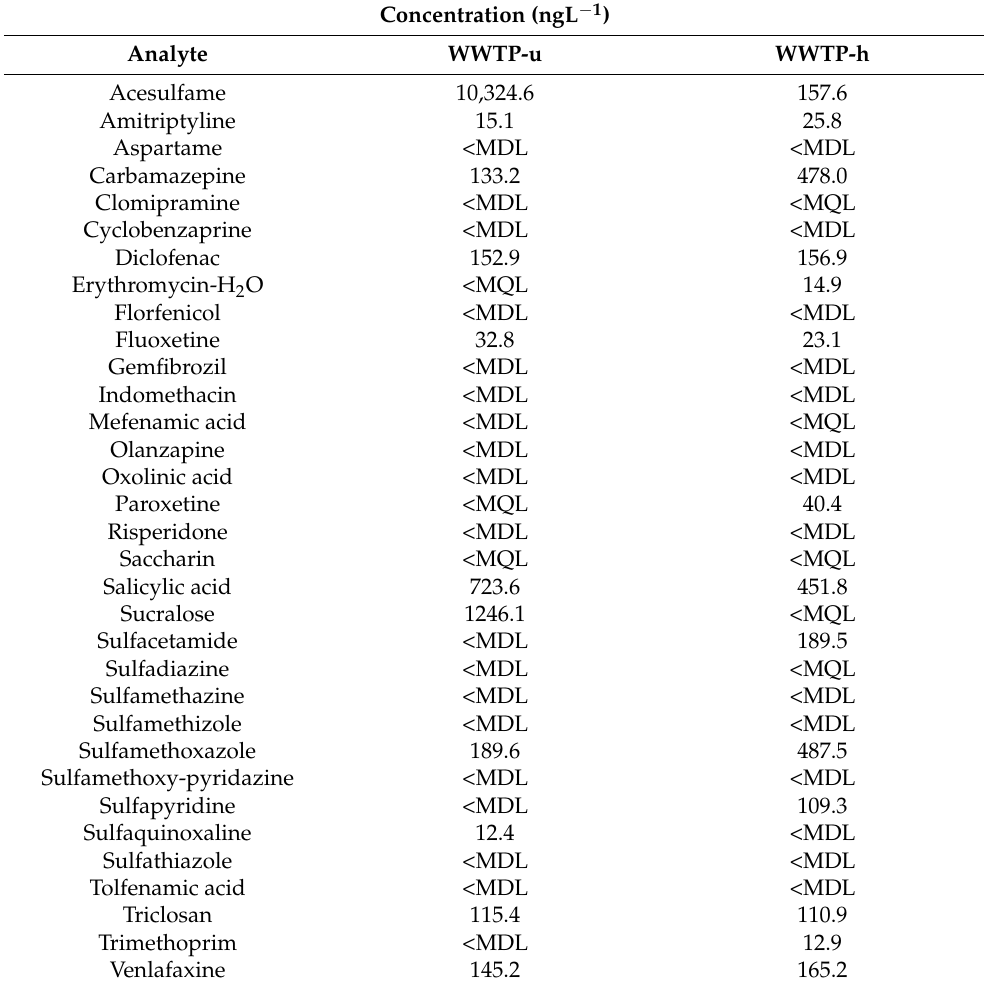
Table 3. Mean concentrations ( n = 3) of target ECs in urban (WWTP-u) and hospital (WWTP-h)